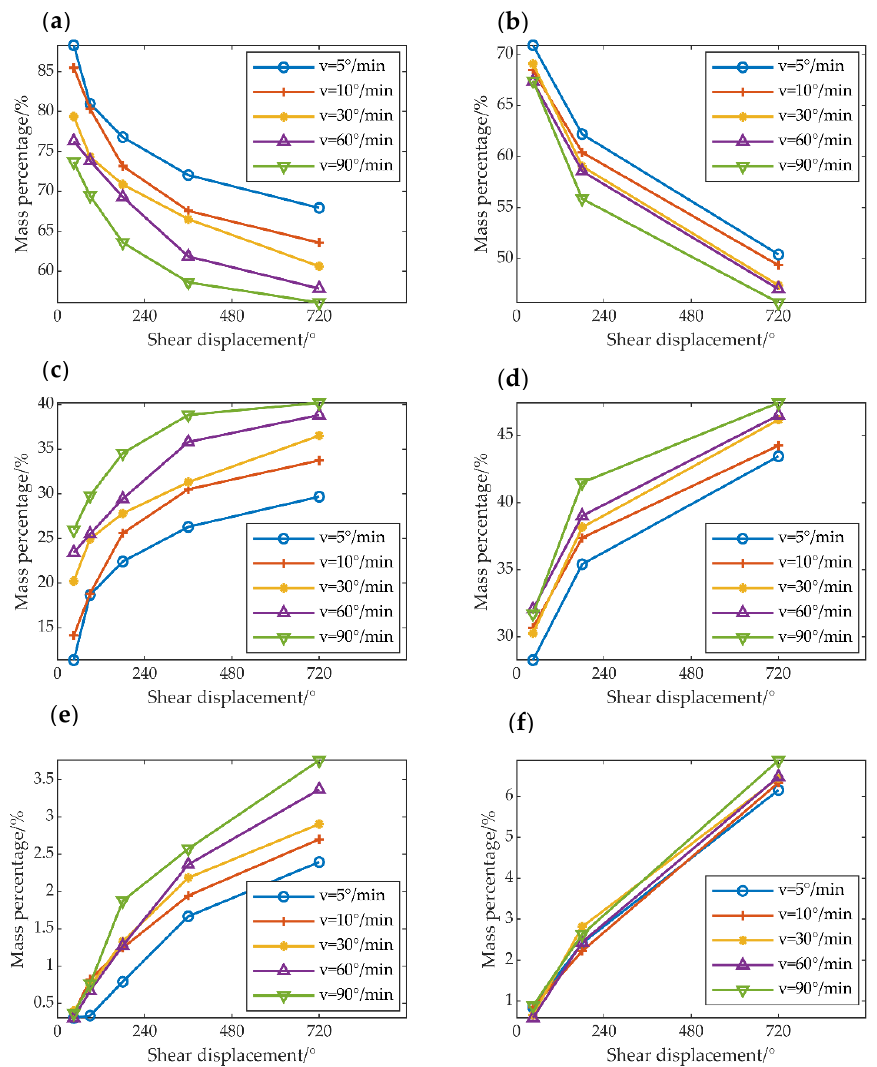
Figure 2. Percentage mass contents of particles of different size after shear crushing: ( a ) unbroken particles in quartz sand, ( b ) unbroken particles in calcareous sand, ( c ) partially broken particles in quartz sand, ( d ) partially broken particles in calcareous sand, ( e ) completely broken particles in quartz sand, and ( f ) completely broken particles in calcareous sand.